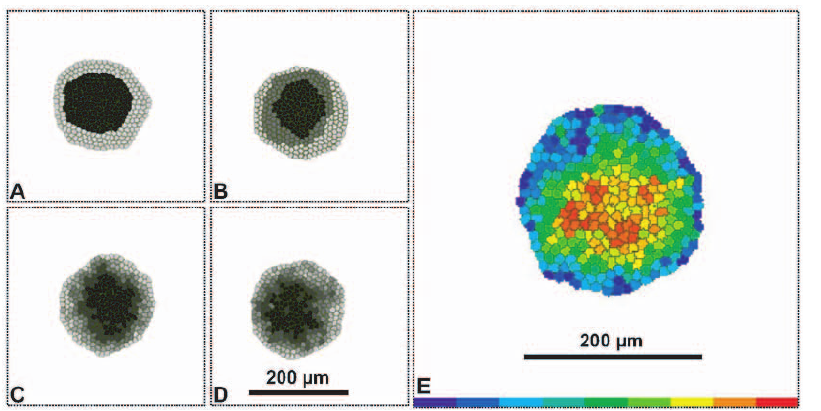
Figure 1. Typical simulated sorted configurations for aggregates of cells for the trans-homophilic-bond model (THBM). All images shown at time t =999,000 MCS. In A–D , the gray-scale represents the cadherin-expression level. The darkest color (gray level=0) represents the highest cadherin-expression level. The lightest color (gray level=200) represents the lowest cadherin-expression level. The cell culture medium is white (gray level=255). In ( E ), HSV colors represent the expression levels, ( H ~ ½ 1 { ( N { N min ) = ( N max { N min ) (cid:2) 255 , S ~ 255 , V ~ 255 ), where N is the cadherin-expression level, and N min and N max are the minimum and maximum cadherin-expression levels, respectively. Red ( H ~ 0 ) is the highest expression level, blue ( H ~ 255 ) the lowest expression level. The cell culture medium is white. Sorting for: ( A ) 2 levels. ( B ) 3 levels. ( C ) 5 levels. ( D ) 9 levels. ( E ) Continuous levels. Cadherin expression ranges from N min ~ 1 to N max ~ 23 . In all simulations, T ~ 20 and l ~ 25 .